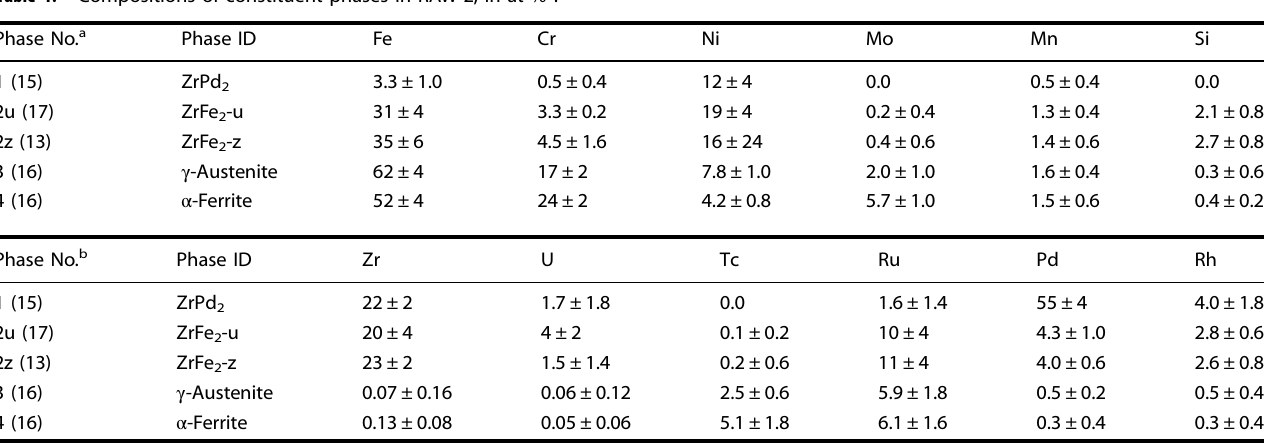
Table 1. Compositions of constituent phases in RAW-2, in at % a . Phase No.